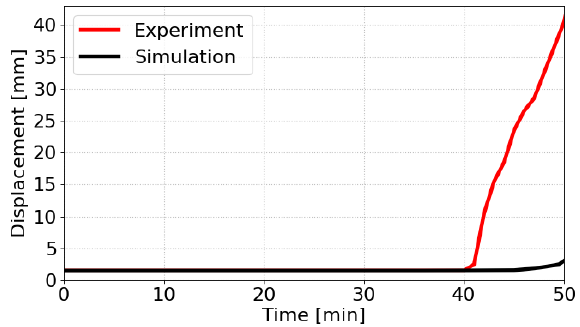
Figure 21. Comparison of the experimental and calculated displacements for beam